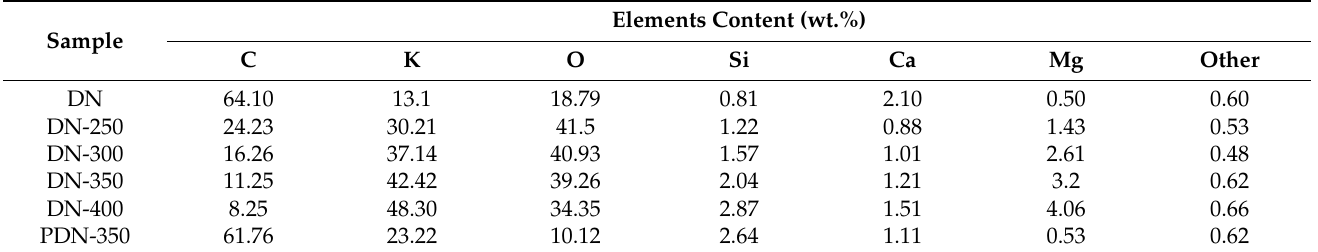
Table 2. EDX analysis of DN-350